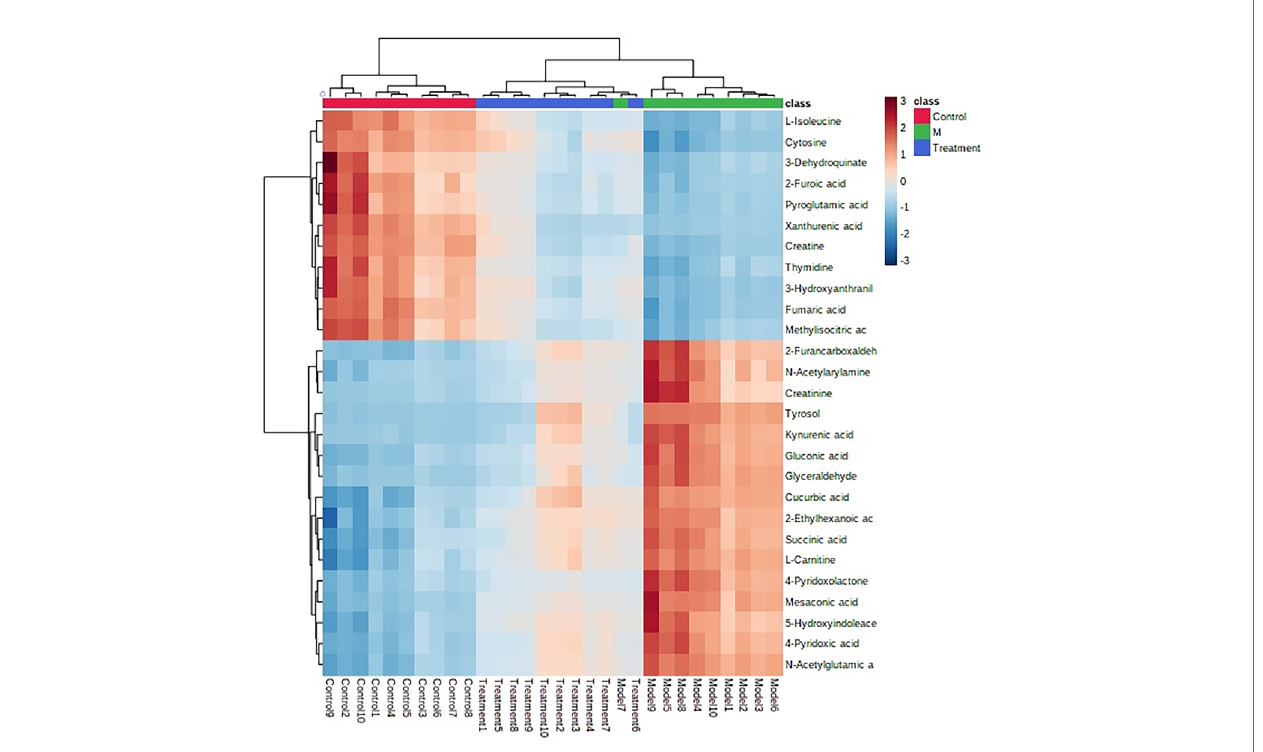
FIGURE 9 | The heatmap analysis for control, model and HNK-treated groups in urine metabolism pro fi le. Heatmap clustering of the potential biomarkers in the different experimental groups. The individual samples are in columns. Samples are identi fi ed by the colored bars on the top. Clustering of the potential biomarkers was performed with the Ward algorithm based on Euclidean distances.